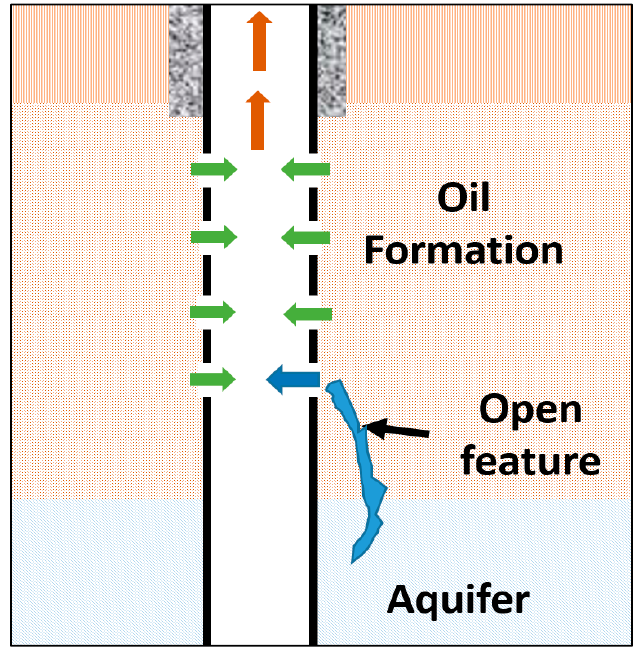
Figure 2. An oil producer connected to an aquifer through an open feature.